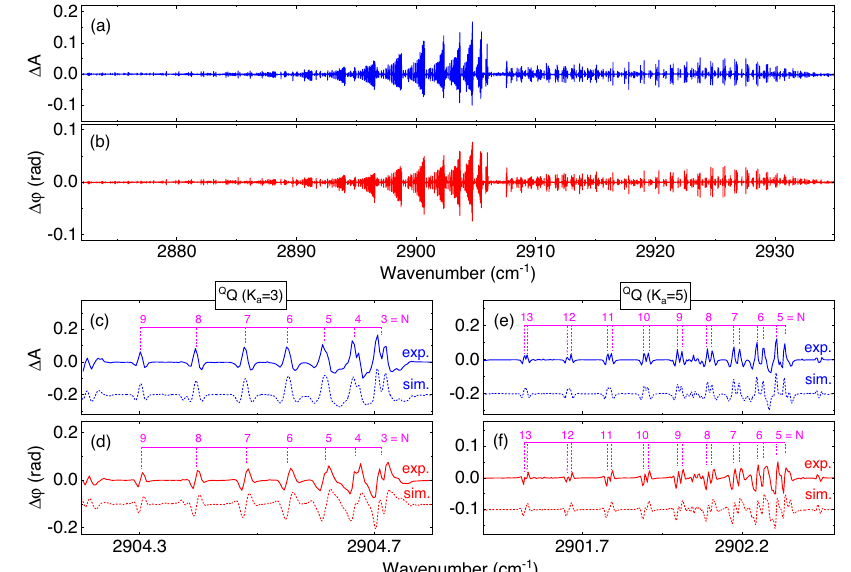
Fig.6|Magneticvibrationallineardichroism(LD)andlinearbirefringence(LB) ofnitrogendioxide.a Differentialabsorbance 4 Abetweenorthogonallypolarized light( 4 A=A π (cid:2) A σ ); b Differentialphase 4 φ between orthogonally polarized light